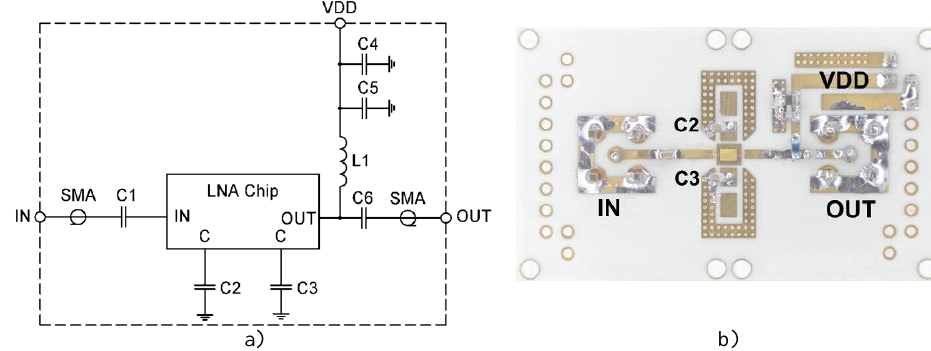
Fig. 4. Special measurement test fixture schematic (а), photograph (b).